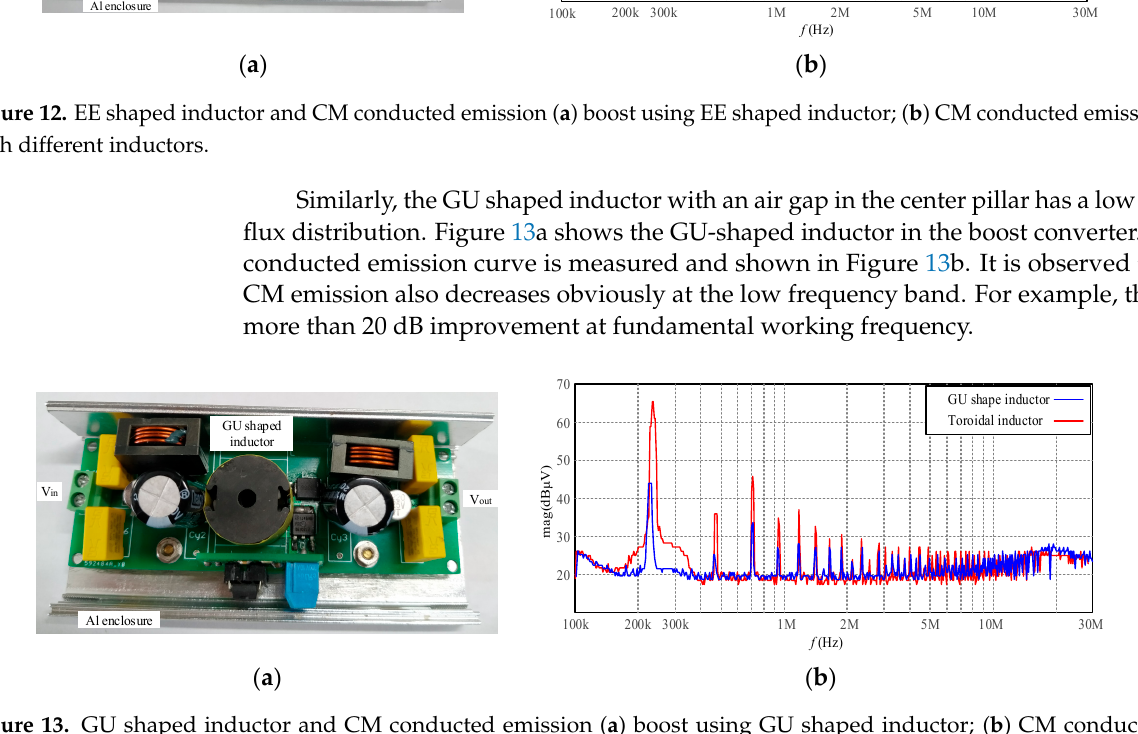
Figure 13. GU shaped inductor and CM conducted emission ( a ) boost using GU shaped inductor; ( b ) CM conducted emission with different inductors.